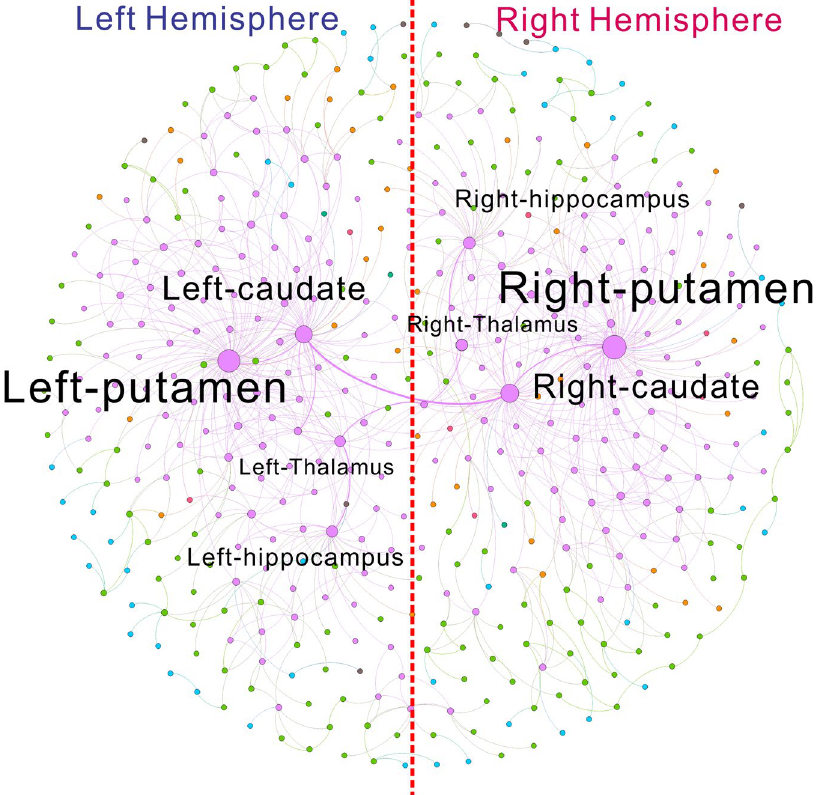
Figure 18. An example application of the proposed localized scaling feature space for characterization of weighted complex network. Interfaced with the unsupervised machine learning based clustering algorithm, the localized scaling based community detection is able to identify the brain network communities consistent with the anatomical facts. The detected communities are not limited to neighboring nodes but based on their relative spatial relations to the rest of network with potential functional